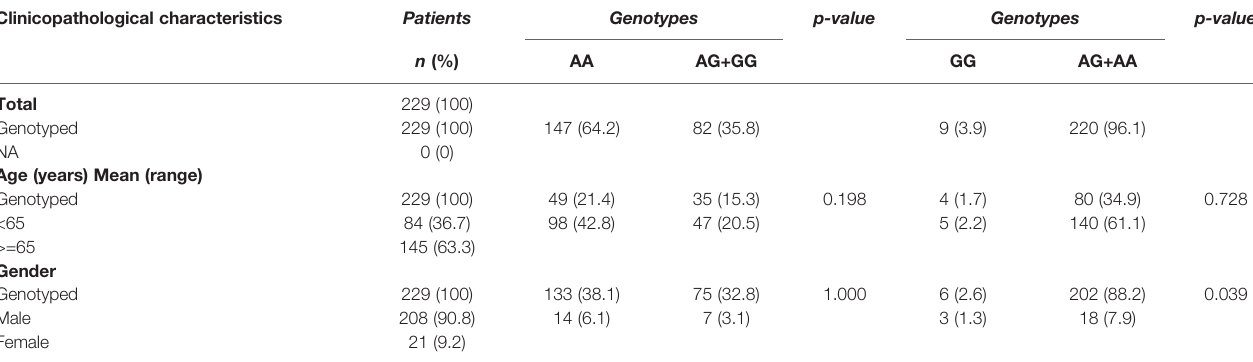
TABLE 7 | Relationships between clinicopathological variables of NSCLC patients and BAFFR rs7290134 genotypes. Clinicopathological